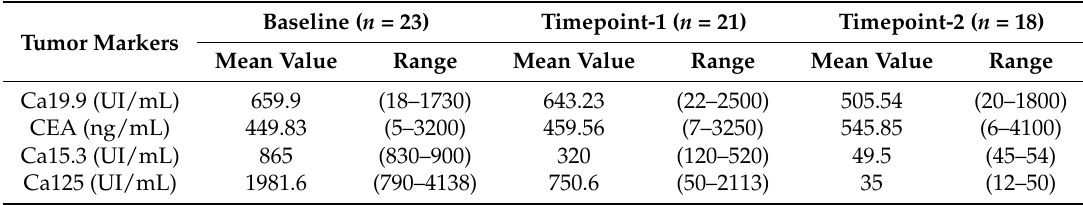
Table 3. Biological circulating tumor markers collected at baseline, timepoint-1, and timepoint-2.